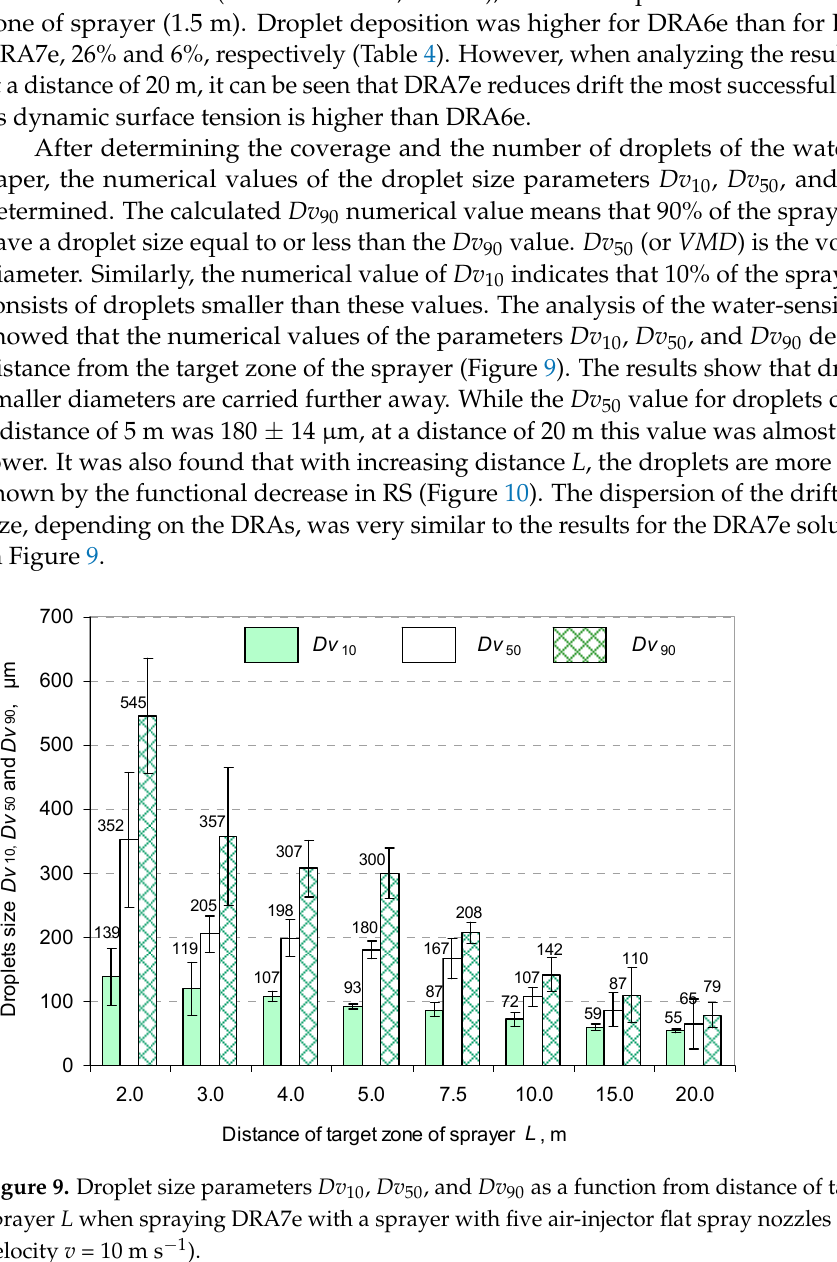
Figure 10. Relative span RS of droplets as a function from distance of target zone of sprayer L when spraying DRA7e with a sprayer with five air-injector flat spray nozzles (lateral wind veloc- ity v = 10 m s − 1 )